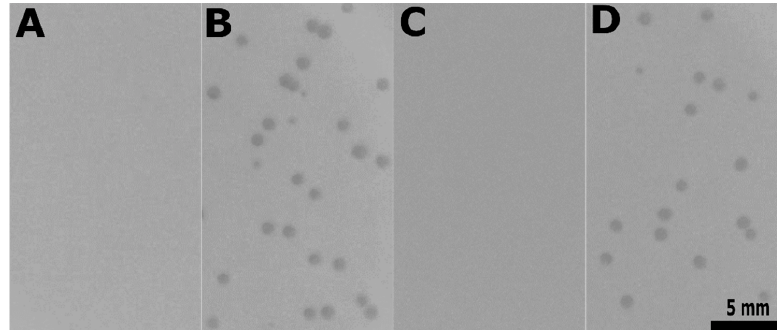
Figure 7. epaX gene expression is required for Idefix infection of pp6 - . Plaque assays performed on strains: ( A ) pp6 - epaX - (VE18393), a VE18306 derivative deleted from epaX . ( B )pp6 - epaX - pVE14176 epaX + (VE18945), a VE18393 derivative complemented with epaX . ( C ) pp6 - epaX - pVE14176 (VE18944), a VE18393 derivative carrying the empty vector. ( D ) pp6 - (VE18306), a V583 derivative deleted from its plasmids and